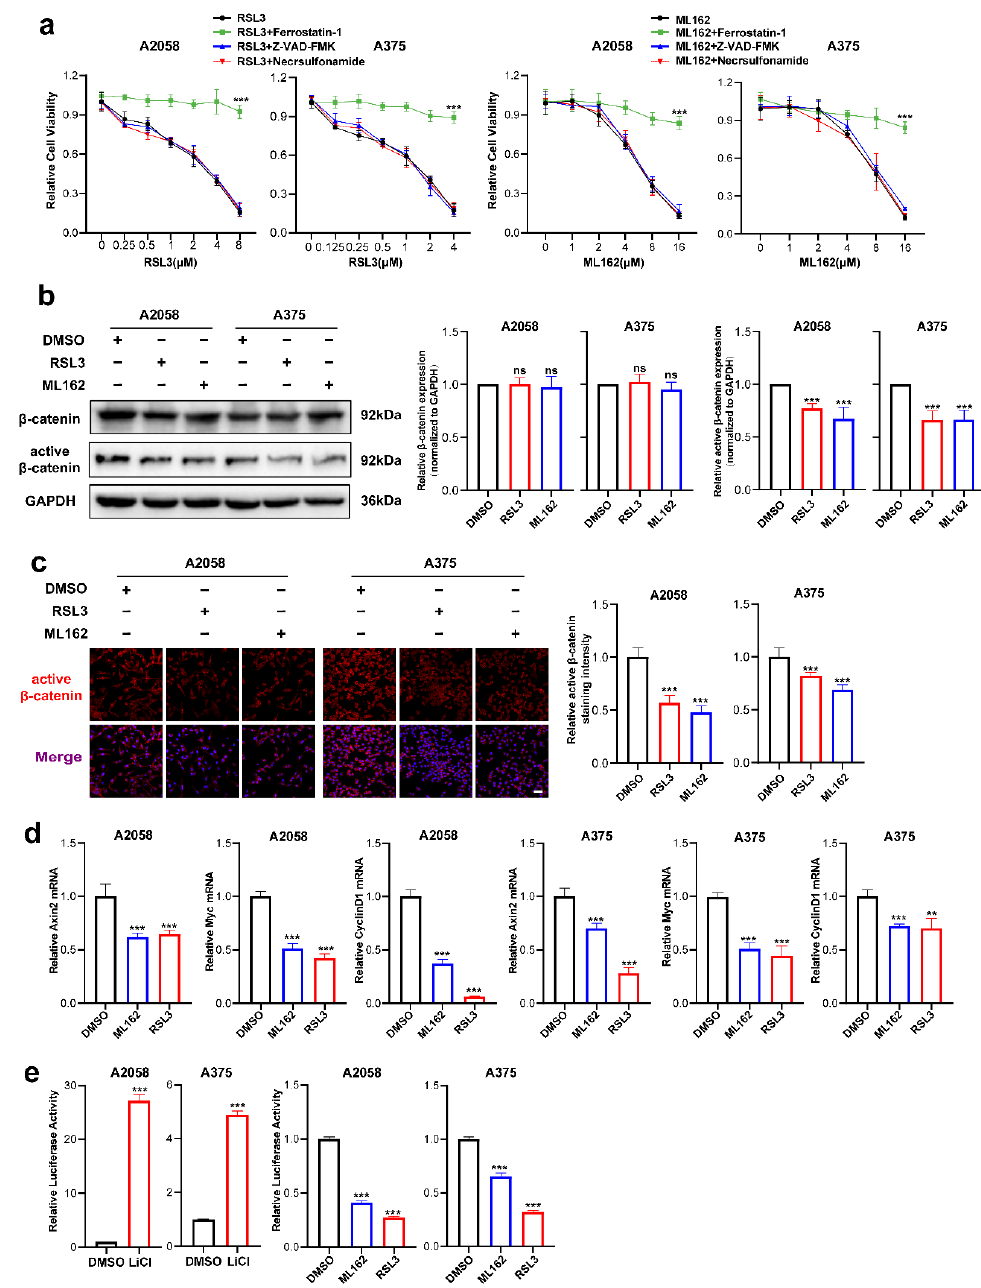
Figure 1. Wnt/ β -catenin signaling is prominently suppressed in melanoma cell ferroptosis. ( a ) Cell viability of (0.125–8 µ M) RSL3 or (1–16 µ M) ML162-stimulated melanoma cells pretreated with 10 µ M ferrostatin-1, 10 µ M Z-VAD-FMK or 0.5 µ M necrosulfonamide for 24 h. ( b ) Immunoblotting analysis of β -catenin and active β -catenin levels in response to either RSL3 or ML162 treatment in both A2058 and A375 melanoma cells for 24 h (RSL3, 2 µ M for A2058 and 0.5 µ M for A375. ML162, 4 µ M for both A2058 and A375). ( c ) IF staining of active β -catenin in response to either RSL3 or ML162 treatment after treatment indicated in ( b ). Scale bars = 50 µ m. ( d ) Relative mRNA levels of Axin2, c-Myc and CyclinD1 after treatment indicated in ( b ). ( e ) Transcriptional activity of β -catenin detected by Topflash reporter assay after the treatment with 20 mM LiCl, RSL3 and ML162 in both A2058 and A375 melanoma cells for 24 h (RSL3, 2 µ M for A2058 and 0.5 µ M for A375. ML162, 4 µ M for both A2058 and A375). Data are presented as mean ± SEM of triplicates. p -value was computed using a two-tailed Student’s t -test. ** p < 0.01 and *** p < 0.001. ns,